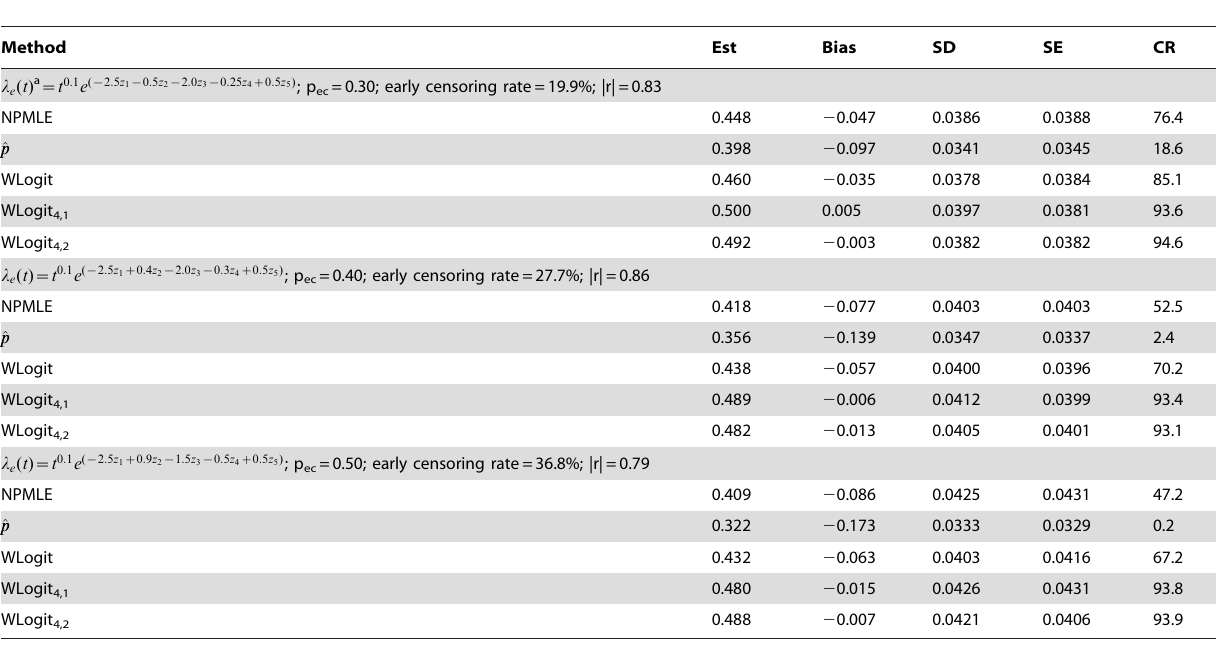
Table 4. Monte Carlo Results: Estimation of recurrence of adenomas at 3 years (true recurrence rate: 0.495) assuming dependent censoring with 5 auxiliary